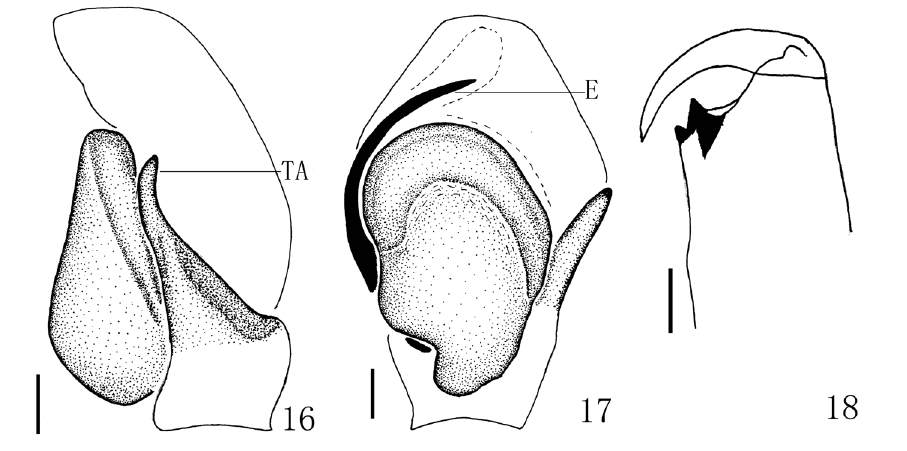
Figures 16–18. Yaginumaella pseudoflexa sp. n. 16 male palp, retrolateral view 17 male palp, ventral view 18 left chelicera, posterior view. Scale bars: 0.1 mm. brown; cervical groove indistinct, radial groove dark brown. Sternum scutiform, cov- ered with short brown hair, dark brown with gray edge. Clypeus dark brown, with long brown setae. Promargin with dense hair. Chelicerae brown to dark brown, with brown hair; 2 promarginal and 1 retromarginal teeth (Figs 18). Labium dark brown, terminal brown, with dark brown hair. Endites base brown, terminal yellow brown, with dense dark brown hair. Legs yellow brown to dark brown; leg I dark brown, I and II